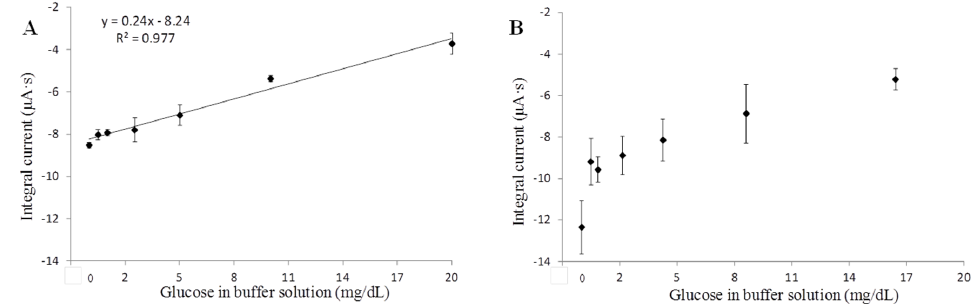
Figure 6. Amperometric tests with the effect of SWNT in support of sensor functionalization ( A ) single-walled carbon nanotubes/(chitosan/gold nanoparticles/glucose oxidase) 3 functional layers; ( B ) (chitosan/gold nanoparticles/glucose oxidase) 3 functional layers without single-walled carbon nanotubes. Error bars = ±standard deviation and n = 3.